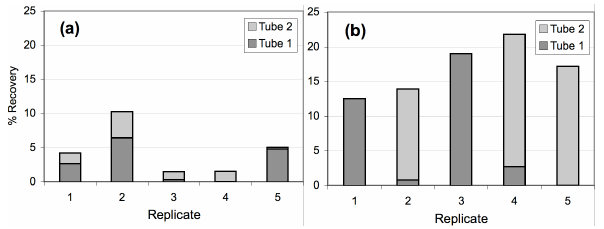
Fig. 3. Percentage recovery of molecular iodine from denuder tubes 1 and 2 in series for (a) freshly coated tubes and (b) tubes coated six months previously. Note that in (a), replicate 4, there is no data for tube